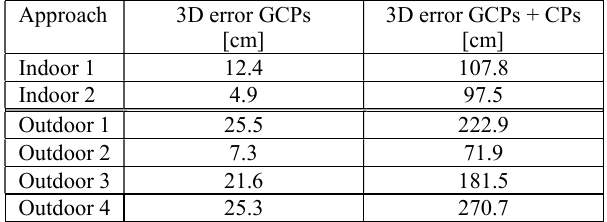
Table 3. comparison of RMSE in GCP between indoor and outdoor